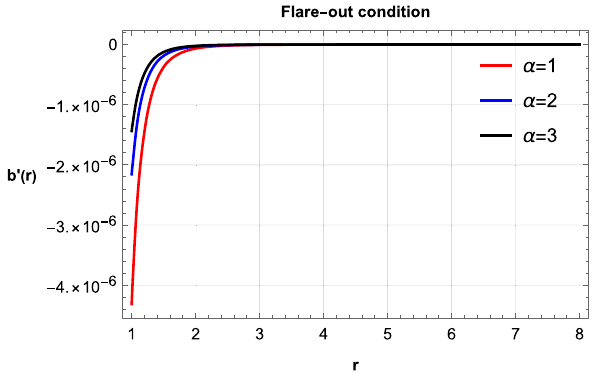
Fig. 9 Flare-out condition for two-sphere (case-1) with r 0 = 1 and A = 0 . 05